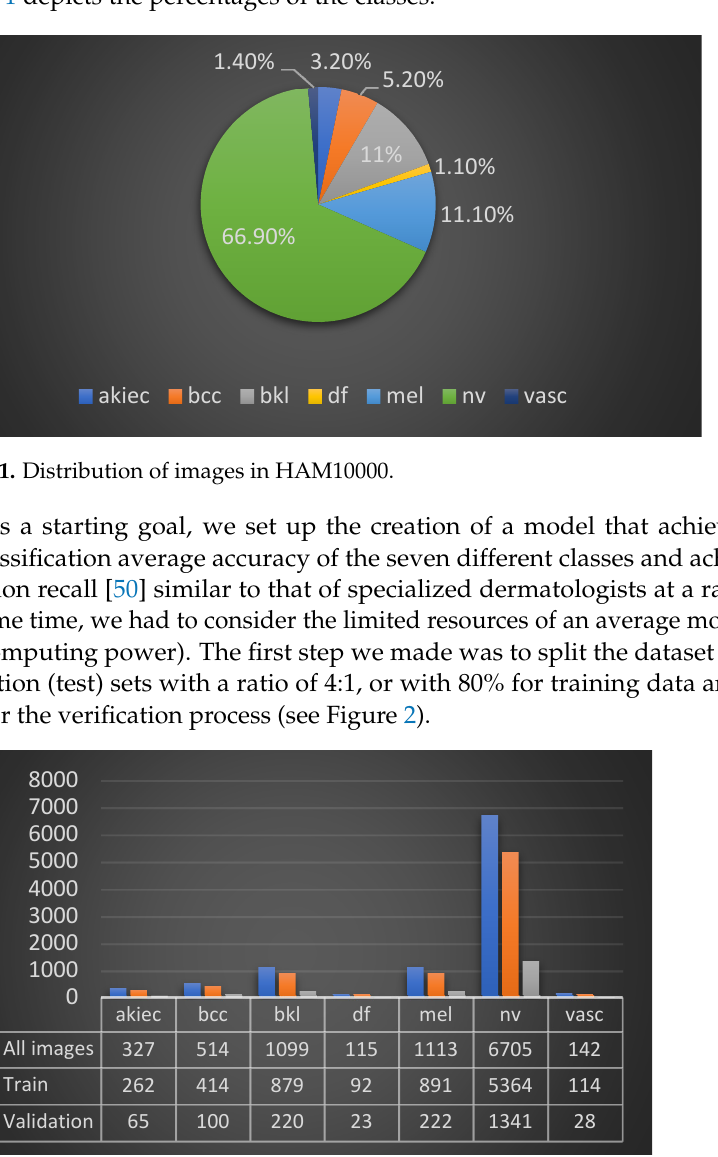
Figure 2. Distribution of images in the HAM10000 dataset of the training–validation split sets.